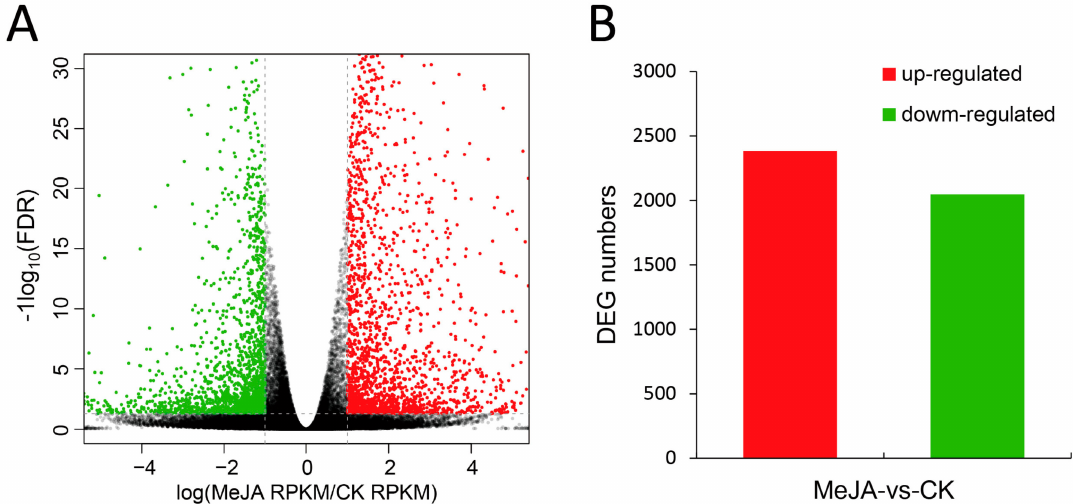
Figure 1. Statistics of DEGs induced by MeJA in M. canadensis transcriptomes. ( A ) Volcano plots of the unigenes in the comparisons of MeJA-treated and CK samples; ( B ) DEG numbers in the comparisons of MeJA-treated and CK samples. RPKM: Reads per Kb per Million Reads, FDR: False Discovery Rate, DEG: Differentially Expressed